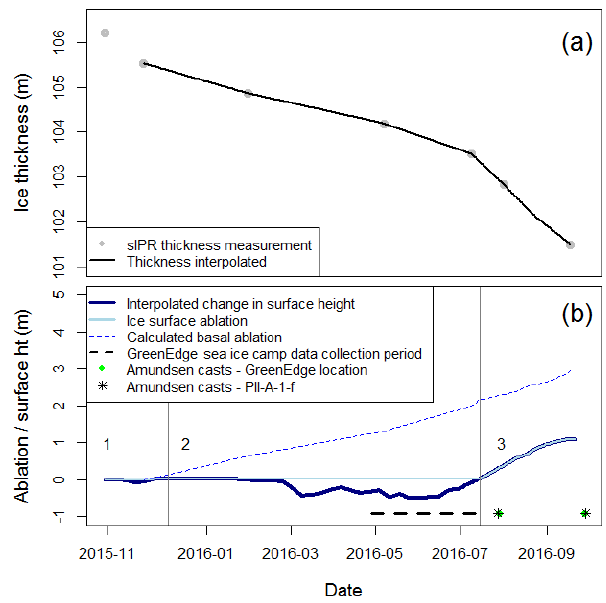
Figure 3. Ablation and thickness change. (a) Thickness change of PII-A-1-f as measured by the stationary ice-penetrating radar (sIPR; grey dots) and interpolated between thickness measurements (black line). The first thickness observation was not included in the inter- polation due to uncertainty imposed by sIPR measurement resolu- tion. (b) Surface and basal ablation as well as the change in surface height (ht) relative to the start of sIPR data collection. The latter, represented by the thick blue line, includes ice ablation (positive values) as well as snow accumulation (negative values). Basal ab- lation is calculated with the linearly interpolated thickness values in (a) and should be taken as an estimate of daily magnitudes. The vertical lines denote three surface ablation periods described in Ta- ble 1. The timing of CTD profiling by the CCGS Amundsen and the time span associated with oceanographic data collection at the GreenEdge sea ice camp are also